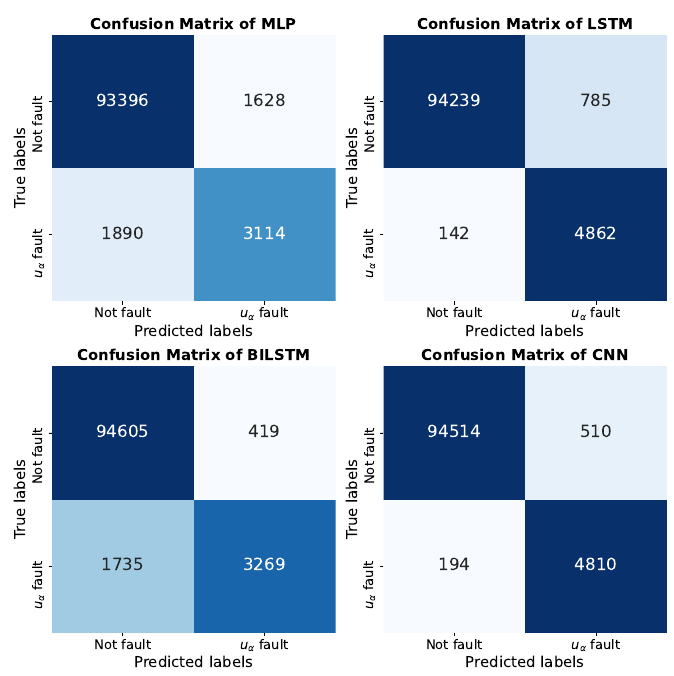
Figure 17. Confusion matrix plot for Channel 4 with 10-d delayed vector.